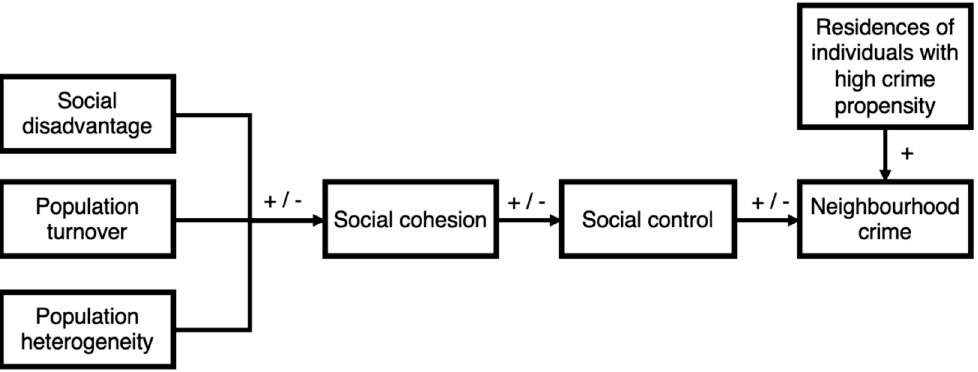
Figure 2. Pathway model illustrating purported socio-demographic influences on crime through CE. Symbols denote an increase or decrease along pathways.